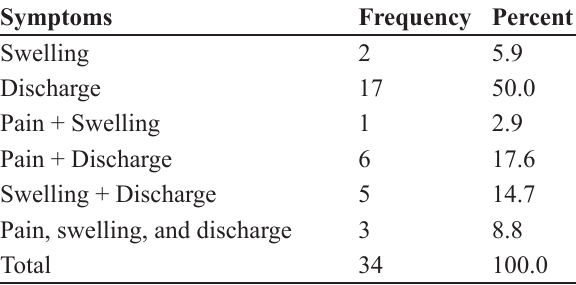
Figure 5: the skin is closed in interrupted sutures